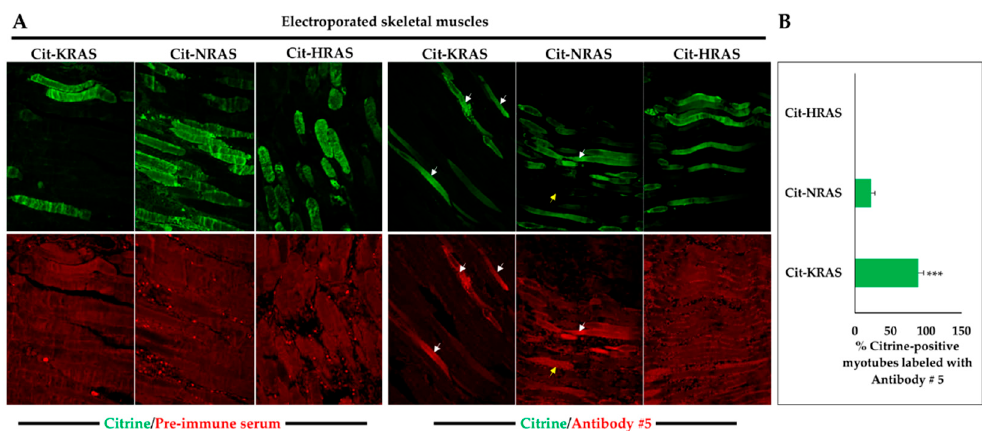
Figure 3. KRAS immunolabeling of electroporated mouse skeletal muscles. ( A ) Immunolabeling performed on electroporated mouse skeletal muscles with citrine-KRAS, citrine-NRAS, and citrine- HRAS (citrine labeling, green) using pre-immune sera (background, red) or antibody #5 (RAS labeling, red). White arrows show myotubes where citrine and KRAS labeling co-localizes. Antibody #5 also recognizes NRAS with lower affinity, as a higher background (yellow arrows) is observed to obtain a specific signal intensity equivalent to that obtained with KRAS. Cit: Citrine. ( B ) Percentage of myotubes co-labeled with citrine and KRAS or NRAS. Data are mean ± SEM. Statistical significance was tested using student’s t -test (***: p < 0.001).